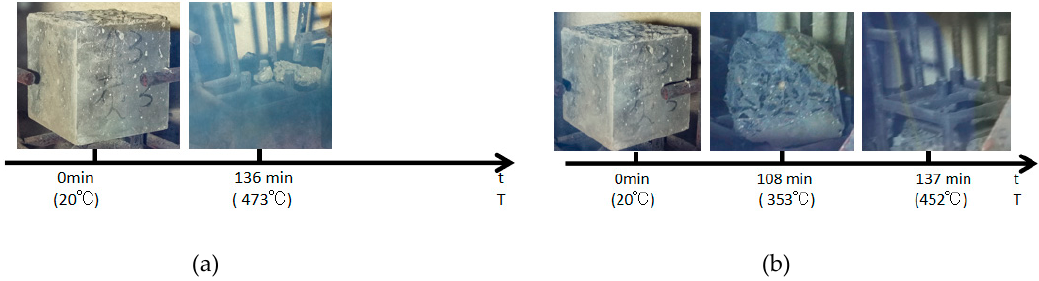
Figure 9. The burst statistics of concrete with different water contents.